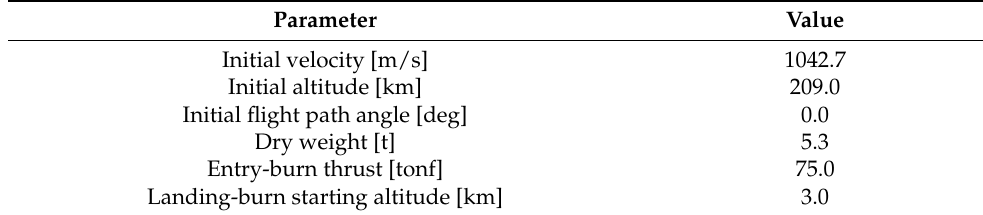
Table 3. Input data for the entry-burn and free-flight modules.